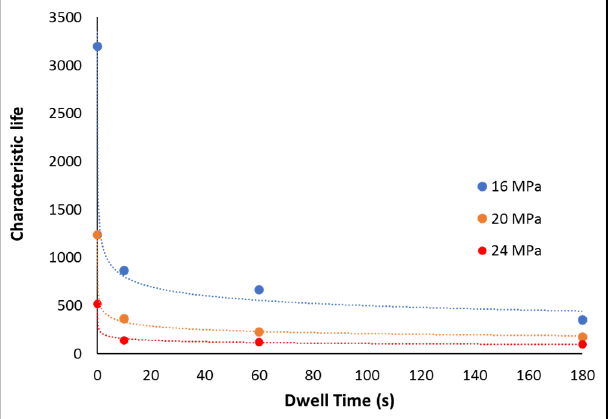
Figure 12. Characteristic life as a function of dwell time for SAC305 solder joints cycled with various stress levels.